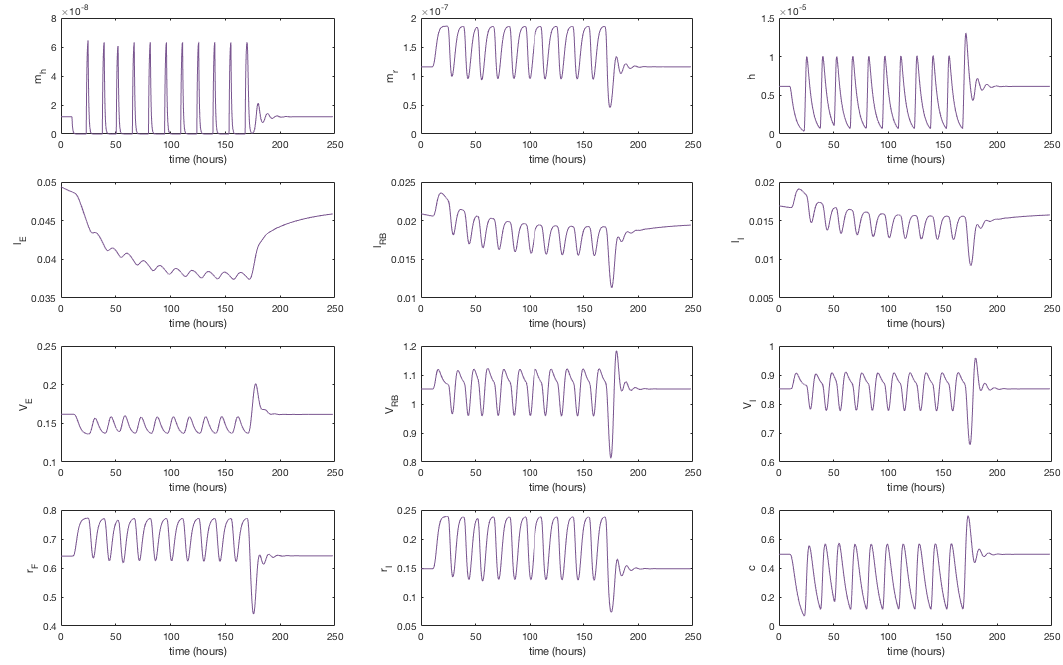
Figure A6. A simulation showing the effect of statin therapy on our integrated model of cholesterol metabolism. Here 11 doses are applied over a seven day period starting at approximately t = 10